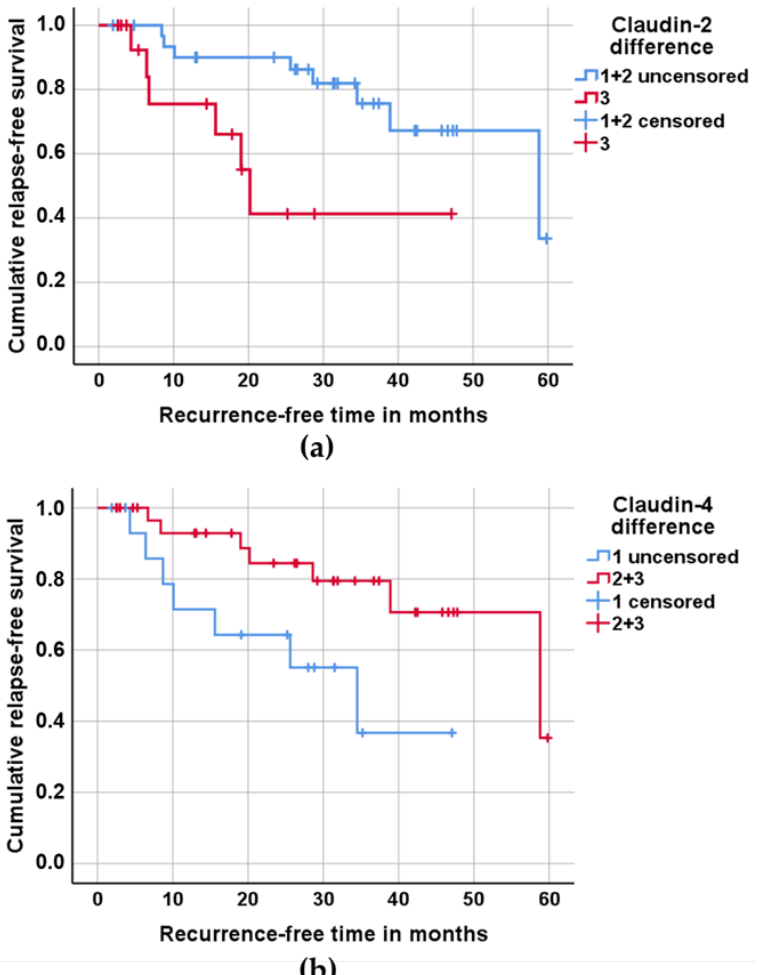
Figure 2. Recurrence-free survival of 49 patients treated and followed up by curative treatment, depending on claudin expression. ( a ) For this analysis, the patients were divided into three groups of equal size based on the differences in claudin-2 expression between tumor tissue and healthy control tissue; group 1, with nearly as much claudin-2 in the tumor tissue as in the control tissue; group 3, with the highest difference in claudin-2 expression between the tumor tissue and control tissue. Groups 1 and 2 were merged for pairwise comparison between groups 1 + 2 and 3 ( p = 0.01). ( b ) For this analysis, the patients were divided into three groups of equal size based on the differences in claudin-4 expression between the tumor tissue and healthy control tissue, with the largest difference between tumor and control in group 1 and the smallest or no difference in group 3. Groups 2 and 3 were merged for pairwise comparison between group 1 and groups 2 + 3 ( p = 0.029). P-values of log-rank